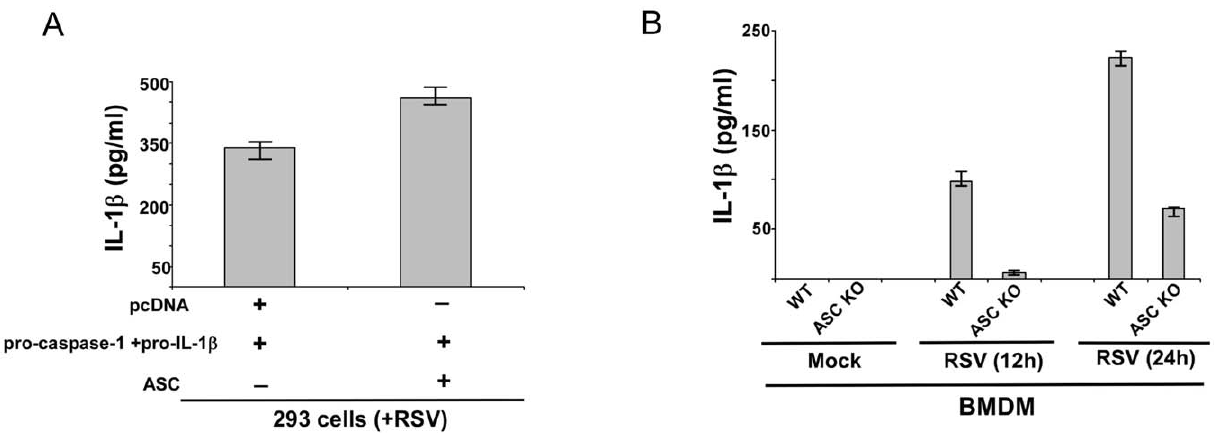
Figure 3. ASC expression is essential for IL-1 b production during RSV infection. ( A ) 293 cells were transfected either with pcDNA (control), pro-IL-1 b + pro-caspase-1 plasmids and ASC plasmid. At 24 h post-transfection, cells were infected with RSV (1 MOI). At 12 h post-infection, medium supernatant was assessed for IL-1 b protein by ELISA analysis. ( B ) Wild type (WT) or ASC knock-out (KO) BMDMs were infected with RSV (1 MOI). IL-1 b levels in the medium supernatant were assayed by ELISA at 12 h and 24 h post-infection. Each value represents the mean 6 standard deviation from three independent experiments.